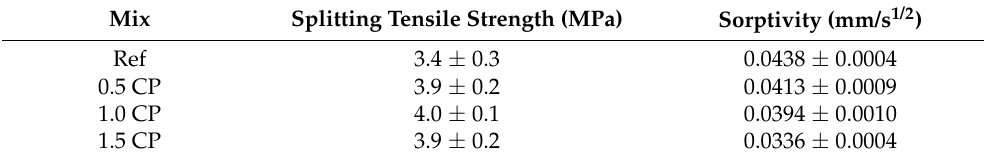
Table 3. 14d mechanical strength and transport property of cement mortar